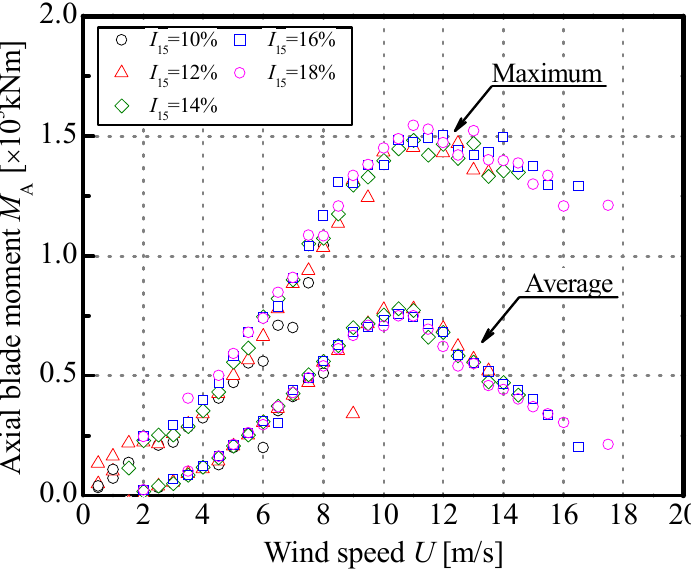
Fig. 8 Averaged and maximum blade root bending moment in wind direction.